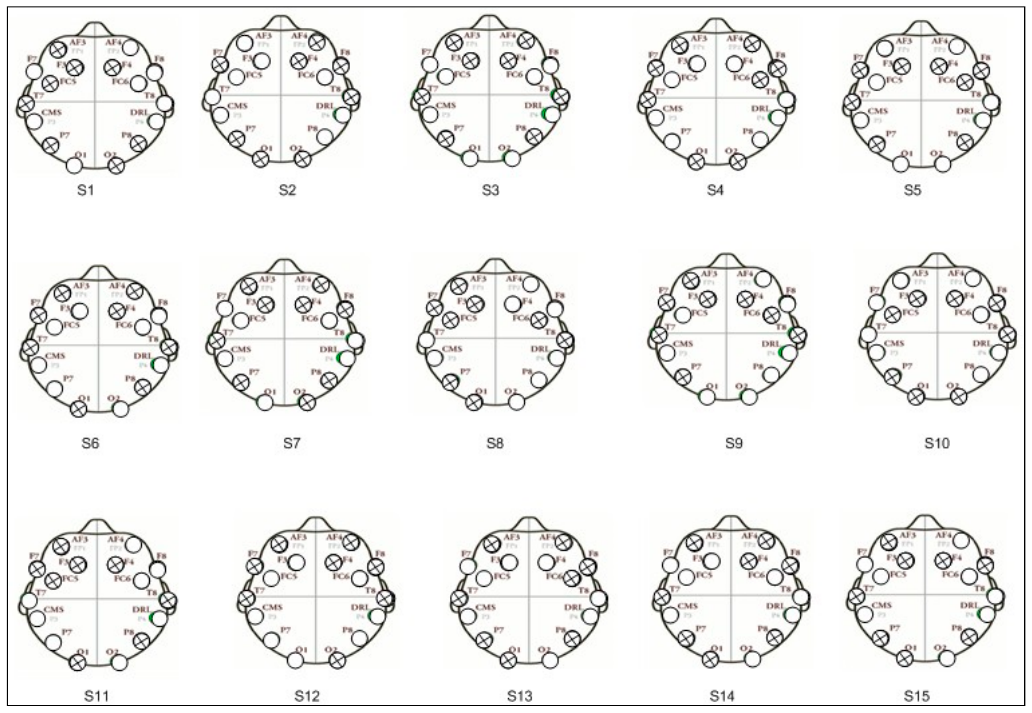
Figure 7. Specification of eight channels’ configurations for each subject.